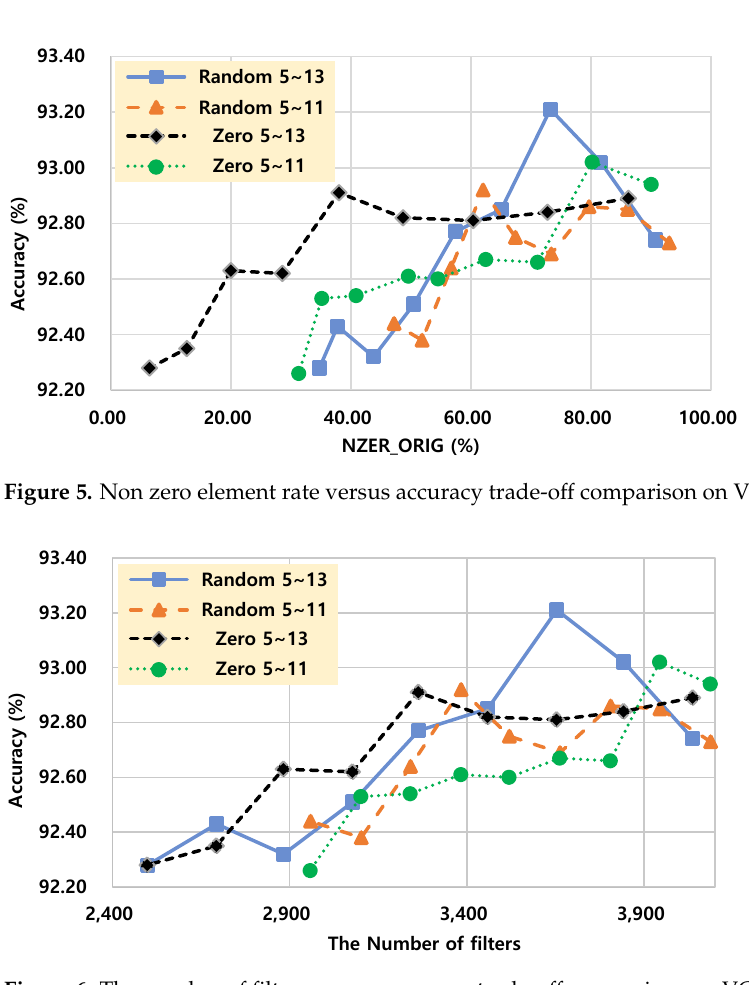
Figure 6. The number of filters versus accuracy trade-off comparison on VGG-16. The experiment results for the Resnet-50 model are presented in Figures 7 and 8. As shown in the graphs, similar patterns are observed consistently with the results obtained from the VGG-16 model. We can see that the proposed method can be well applied not only to a typical CNN model such as VGG-16, but also to a complex model composed of bottleneck blocks and skip connections such as Resnet-50.